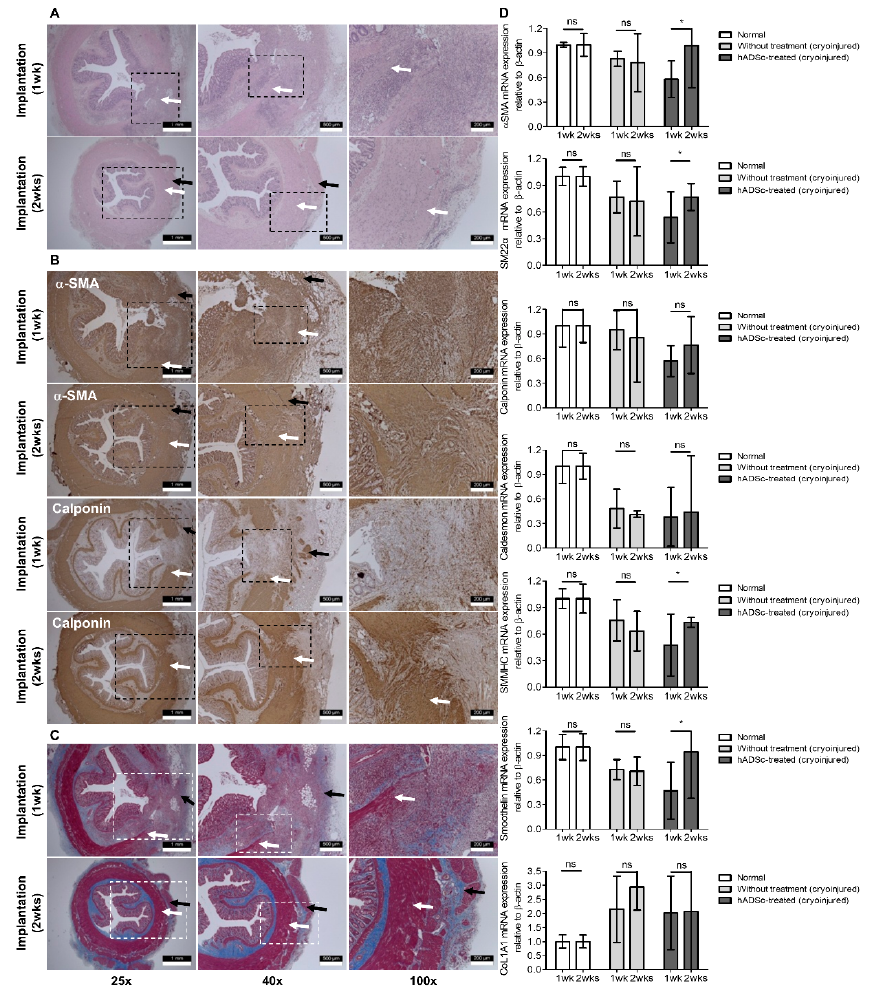
Figure 4. Cell treatment based on the internal anal sphincter-specific incontinence model. Histologic examination after ( A ) H&E staining, ( B ) immunofluorescence staining for α -SMA and calponin, and ( C ) Masson’s trichrome staining 1 and 2 weeks after hADSc implantation at the cryoinjury site (dotted line box). Histology showed the regenerated smooth muscle in the internal anal sphincter (white arrow) with intact mucosa, submucosa, and circular external anal sphincter muscle layers (black arrow). ( D ) RT-PCR analysis of SMC markers in the normal, without treatment (only cryoinjured), and hADSc-treated groups based on α -SMA , SM22 α , calponin , caldesmon , SMMHC , smoothelin , and CoL1A1 . H&E, hematoxylin and eosin; α -SMA, α -smooth muscle actin; hADSc, human adipose- derived stem cell; RT-PCR, real-time polymerase chain reaction; SMMHC, smooth muscle myosin heavy chain. Data are expressed as the mean ± SD; * p < 0.05; ns = no statistical